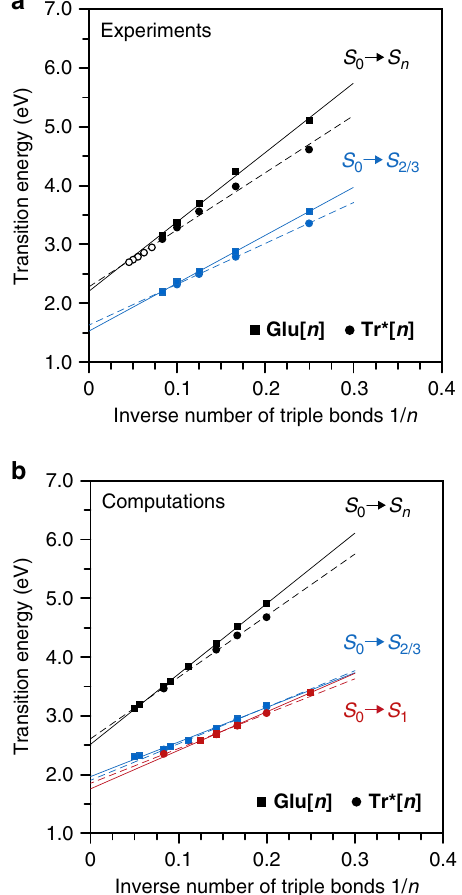
Fig. 4 Extrapolation of experimental and computational transition energies. a Plot of the energies of the experimentally determined S 0 → S n (main) transitions and the S 0 → S 2/3 (weakly allowed) transitions against the inverse number of carbon – carbon triple bonds 1/ n for Glu[ n ] in DCM and Tr*[ n ] in hexane (open symbols: values for Tr*[ n ] |from the literature) 17 . b Plot of the energies of the computationally determined S 0 → S n (main), S 0 → S 2/3 (weakly allowed), as well as S 0 → S 1 (forbidden) transitions against the inverse number of carbon – carbon triple bonds 1/ n for Glu[ n ] in DCM and Tr*[ n ] in hexane. The saturation values have been determined by linear extrapolation to the Glu[ n ] data (solid lines) and the Tr*[ n ] data (dashed lines). Source data are provided in the Source Data fi